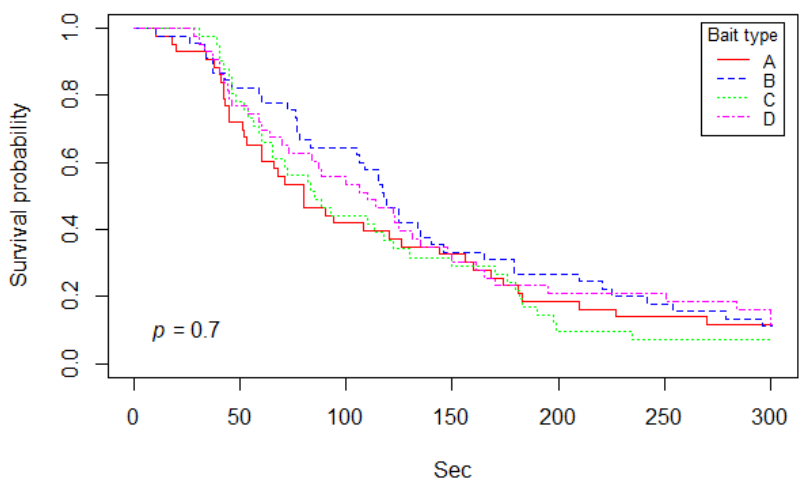
Figure 5. Kaplan–Meier curve of bait handling time separated based on bait type (A, B, C, and D).